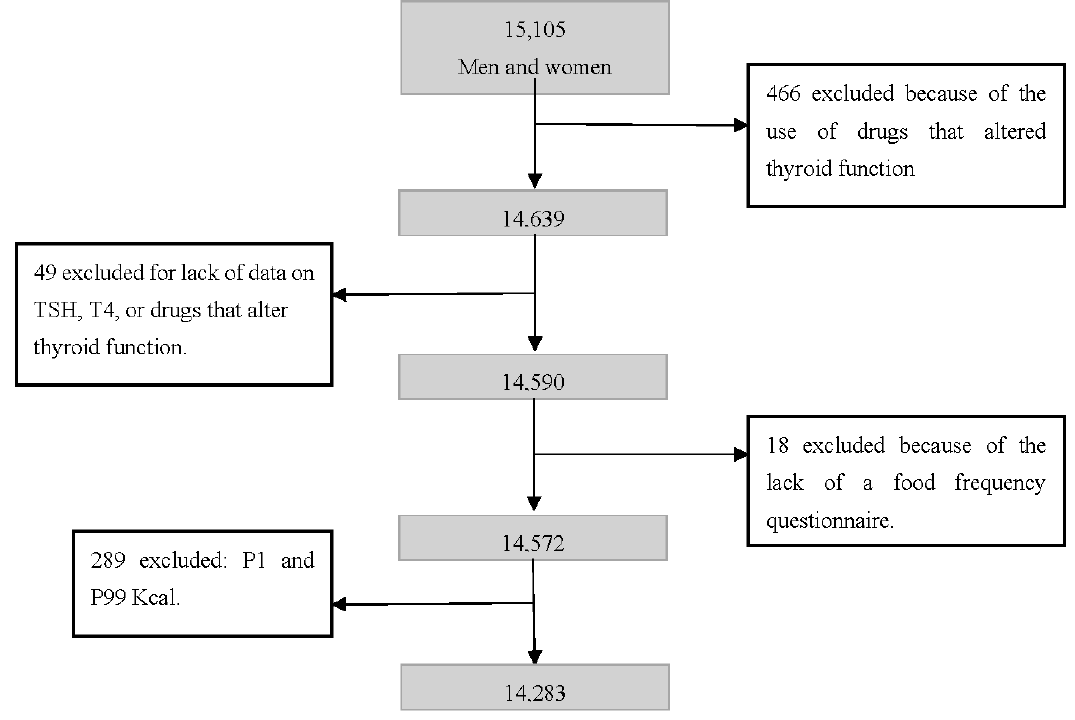
Figure 1. Exclusion criteria and final sample. ELSA-Brasil, Brazil 2017.